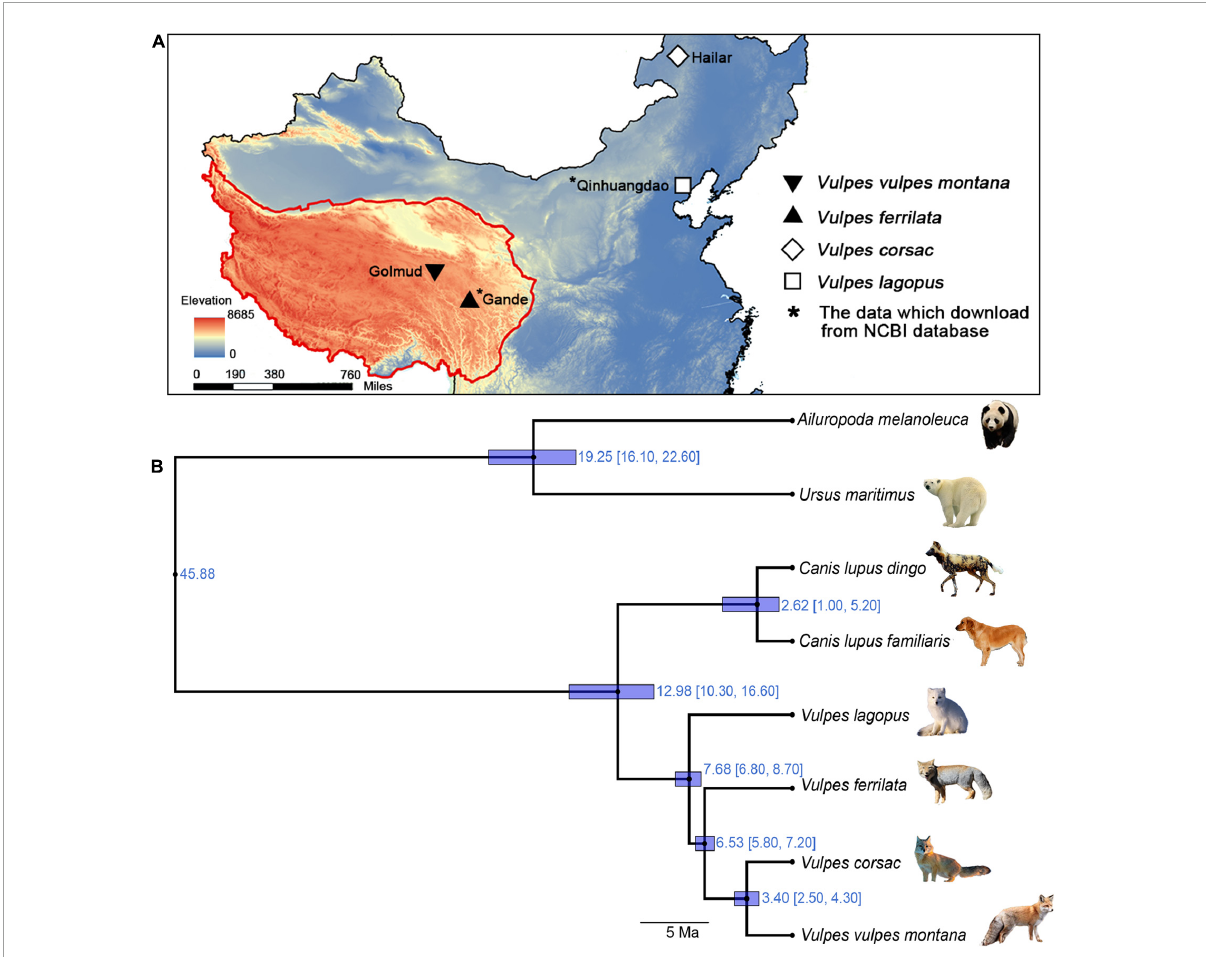
FIGURE1 Localities and phylogenetic relationships of the 4 Vulpes . (A) Sampling locations. (B) Phylogenetic relationships and divergence time. Phylogenetic relationships between Vulpes (i.e., Vulpes lagopus , Vulpes vulpes montana , Vulpes ferrilata , and Vulpes corsac ) and four Carnivora species ( Ailuropoda melanoleuca , Ursus maritimus , Canis lupus familiaris , and Canis lupus dingo ) based on one-to-one single-copy